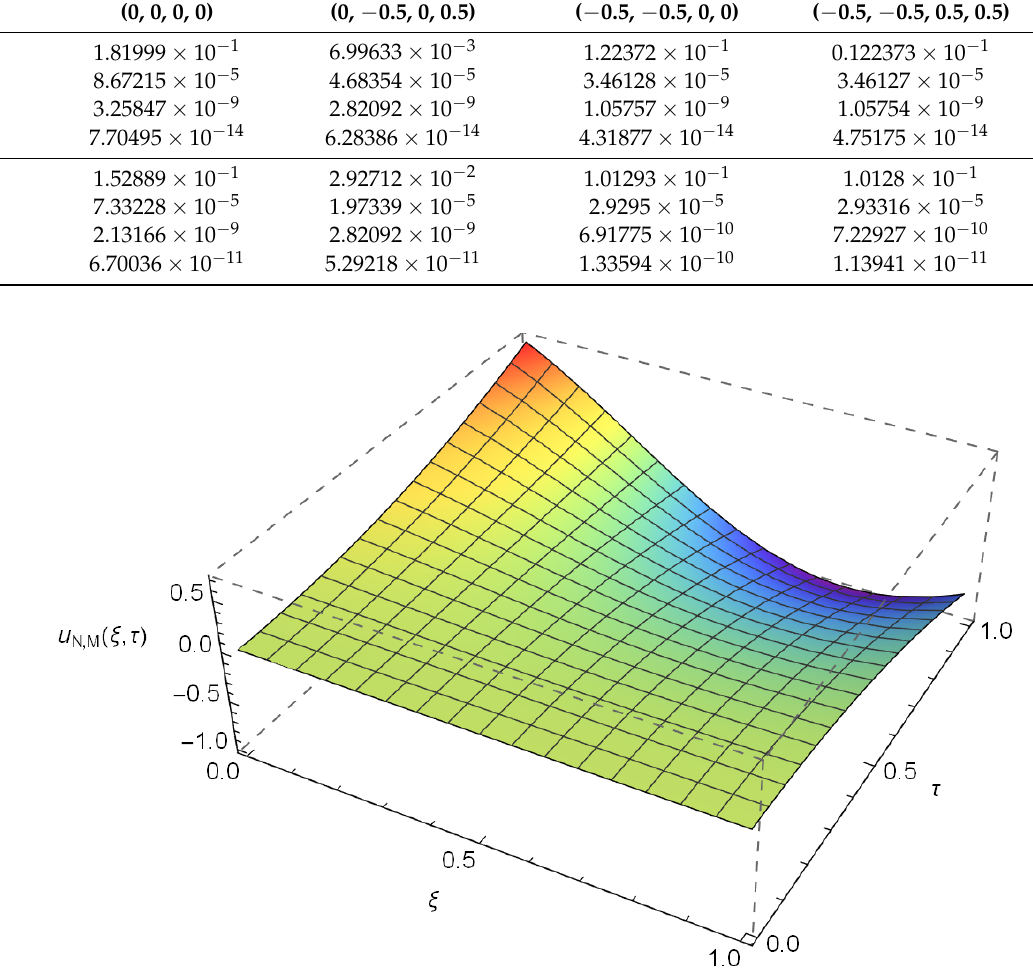
Figure 10. Numerical solution of the problem (33), where σ 1 = (cid:36) 1 = σ 2 = (cid:36) 2 = 0, ν = 0.9 and N = M =